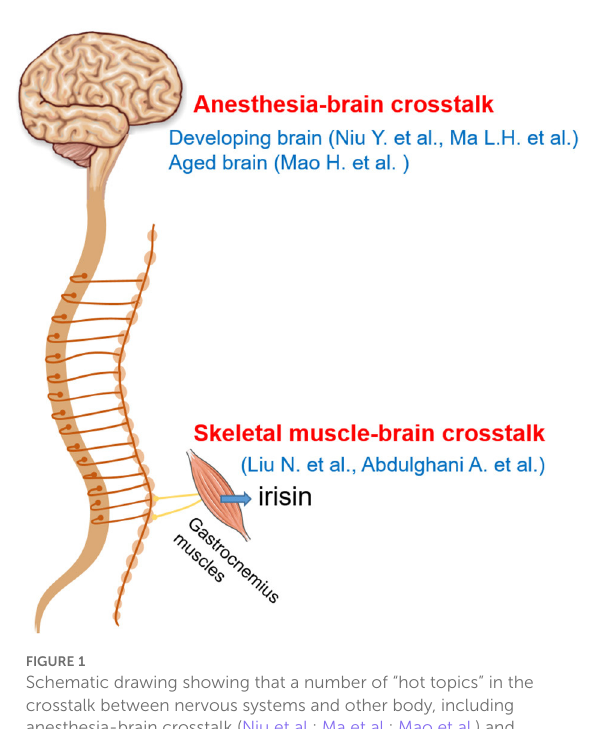
FIGURE1 Schematic drawing showing that a number of “hot topics” in the crosstalk between nervous systems and other body, including anesthesia-brain crosstalk (Niu et al.; Ma et al.; Mao et al.) and skeletal muscle-brain crosstalk (Liu et al.; Abdulghani et al.). Some drawings were taken from Fan et al. (2020, Journal of Neuroscience